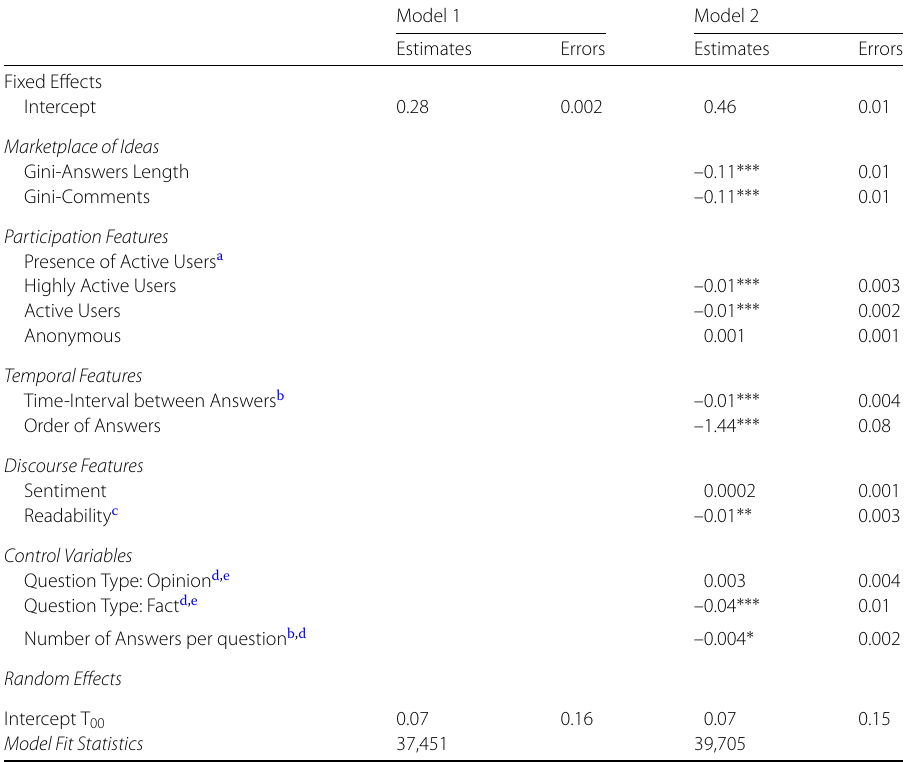
Table 1 HLM regression for information accumulation